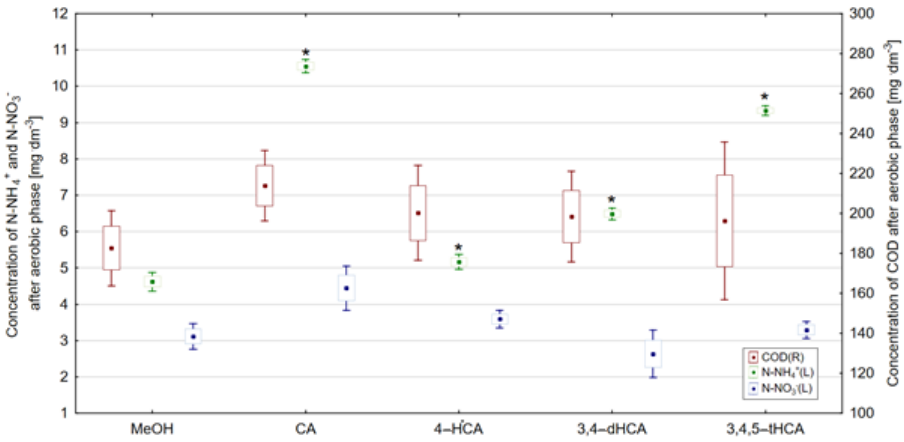
Figure 13. Concentration of N-NH 4+ , N-NO 3 − , and COD after aerobic phase, *—result differing with statistical significance at α = 0.05 in accordance with the control reactor (point—arithmetic mean, box—standard error, line—standard deviation).